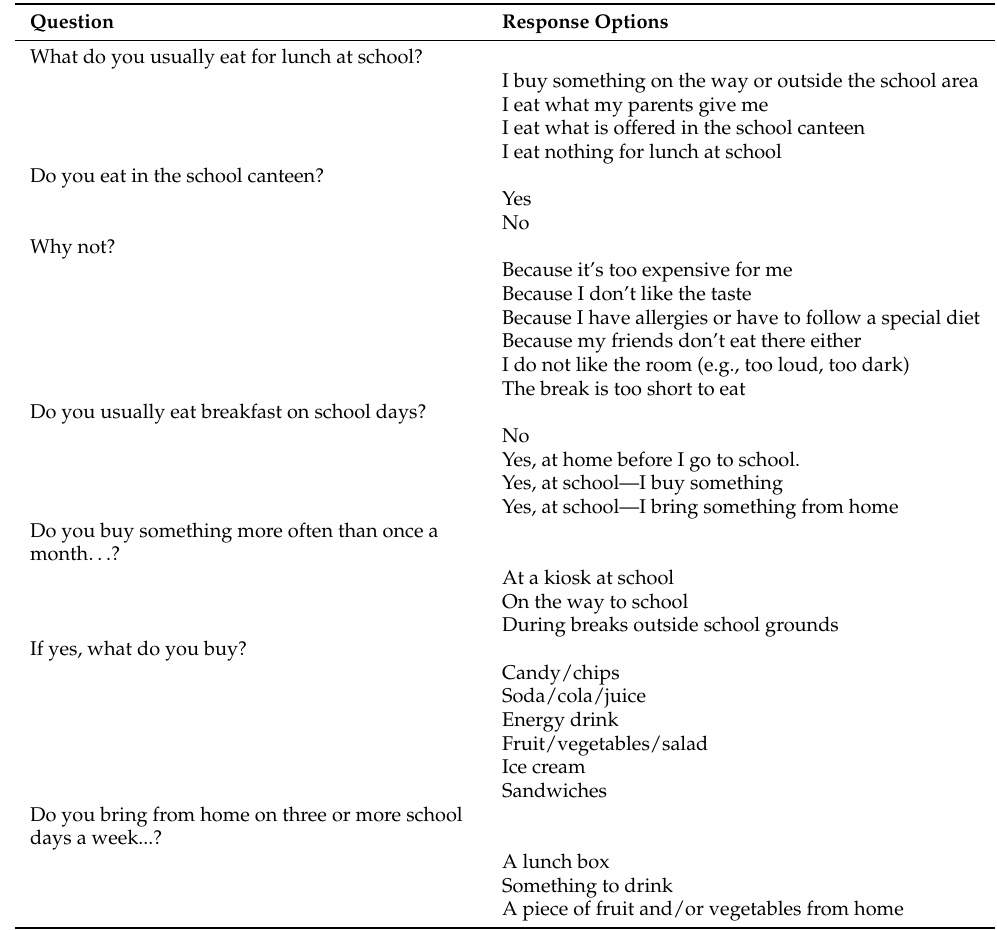
Table 1. List of items regarding “eating behavior” (child